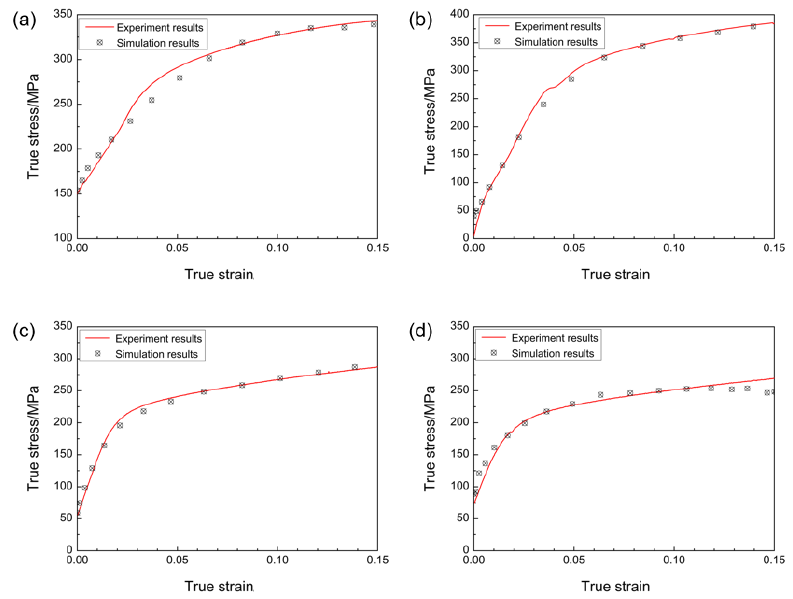
Figure 12. Experimental and simulation comparison of stress – strain curves of sampling plate by asymmetric rolling: ( a ) SR-3.4 mm plate, ( b ) ASR-1.5 mm plate, ( c ) ASR-0.75 mm plate, and ( d ) ASR-0.5 mm plate.